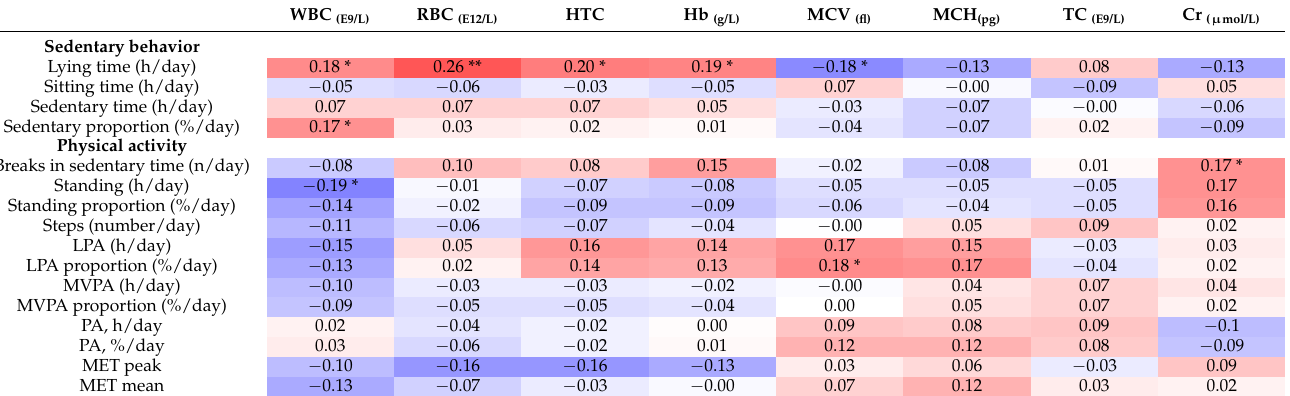
Table 4. Heatmap of age- and sex-adjusted Pearson partial correlation coefficients between sedentary behavior, physical activity and blood count parameters and Cr (model